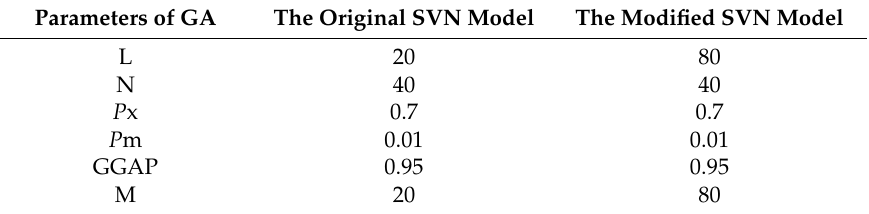
Table 2. Parameters involved in the genetic algorithm (GA)-based parameter calibration method. Parameters of GA